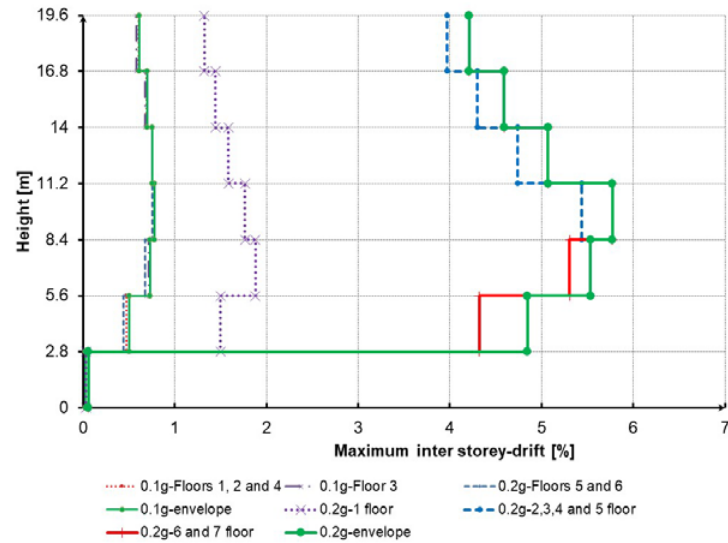
Figure 12. Maximum inter-storey drift for PGA 0.1g and PGA 0.2g scaled accelerograms.